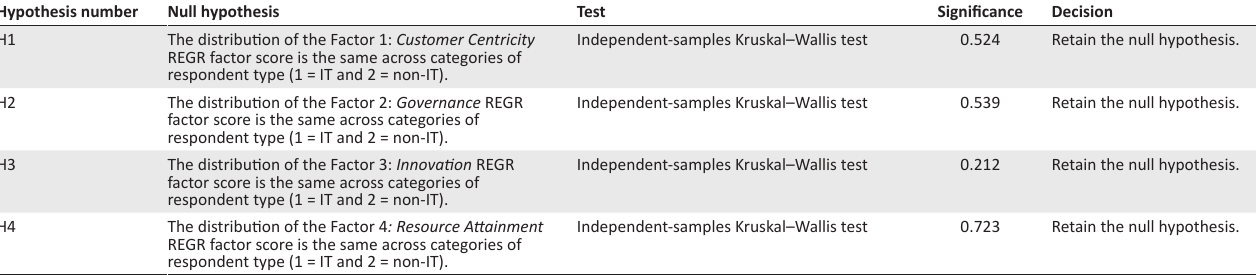
TABLE 6: SPSS output of the hypothesis test summary. Hypothesis